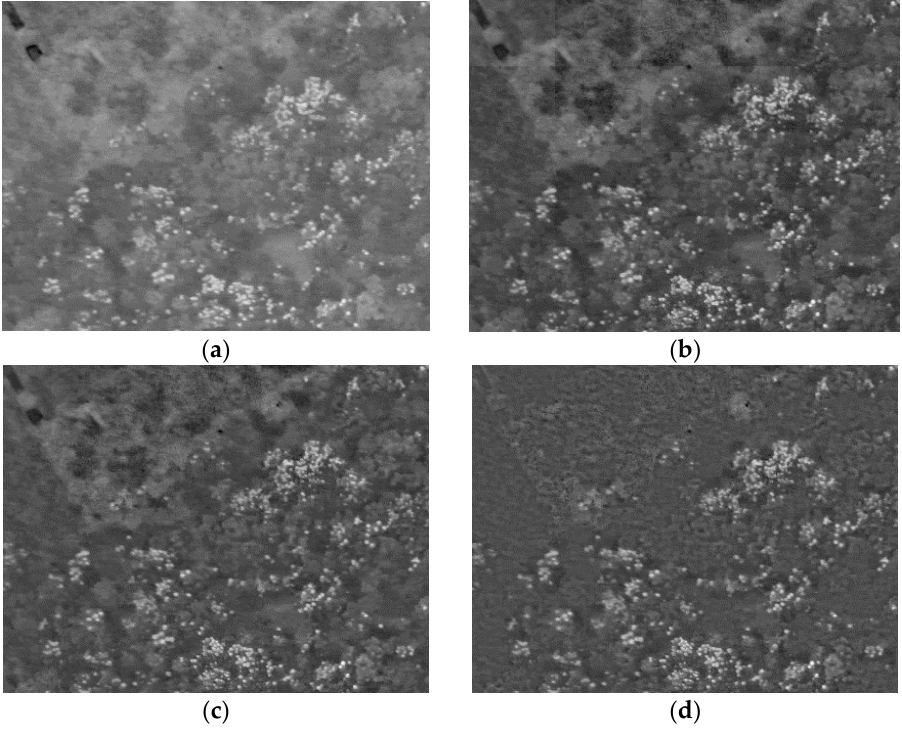
Figure 14. Detection maps of 4 algorithms in Region 1. ( a ) CEM ( b ) Subset CEM ( c ) Sliding Window-based CEM (SW CEM) ( d ) Adaptive Window-based CEM (ASW CEM).